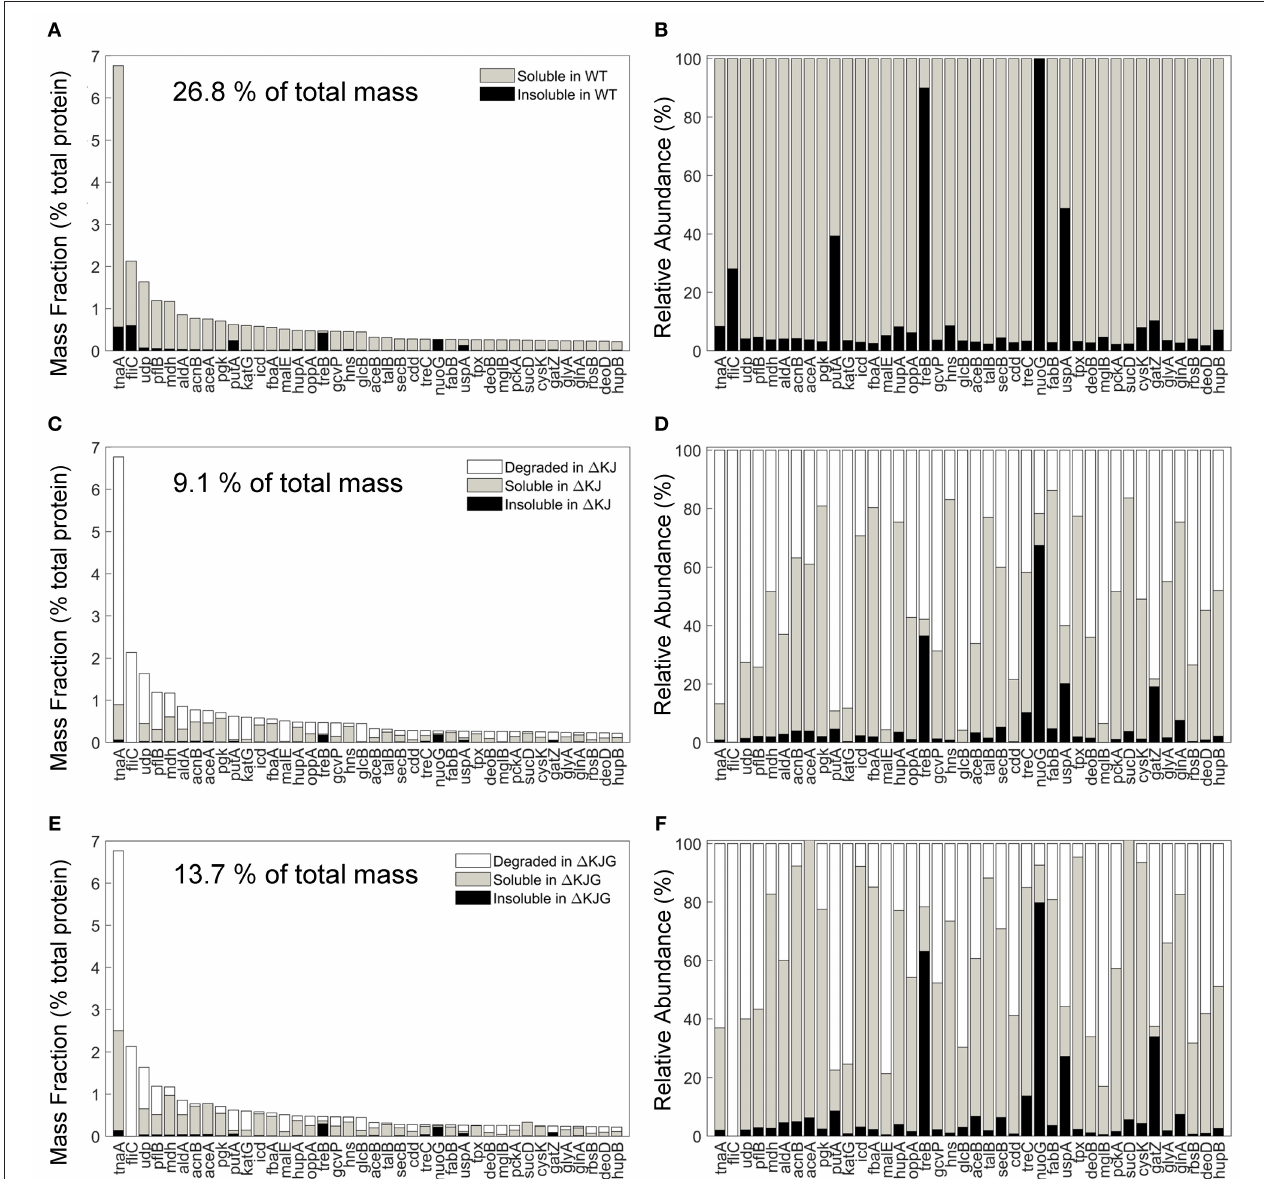
FIGURE 6 | Protein degradation is a prevalent phenotype in 1 KJ and partially rescued in 1 KJG. (A) Absolute abundances (mass fractions of the total cellular protein amount) in wild-type (WT) soluble and insoluble fractions for the 40 most abundant proteins of WT Escherichia coli that were downregulated in 1 KJ. (B) Normalized abundances in WT E. coli of the same proteins as in (A) . (C) Absolute abundances of the same proteins as in (A) , but with a partitioning showing the amounts of each protein degraded in 1 KJ (white bars); the soluble (gray bars) and insoluble (black bars) amounts in. (D) Same as in (C) , with normalized abundances. (E) Same absolute abundances as in (A,C) , but partitioned in order to show the quantities degraded in 1 KJG with respect to WT (white bars); the soluble (gray bars) and insoluble (black bars) amounts in 1 KJG. (F) Same as in (E) , with normalized